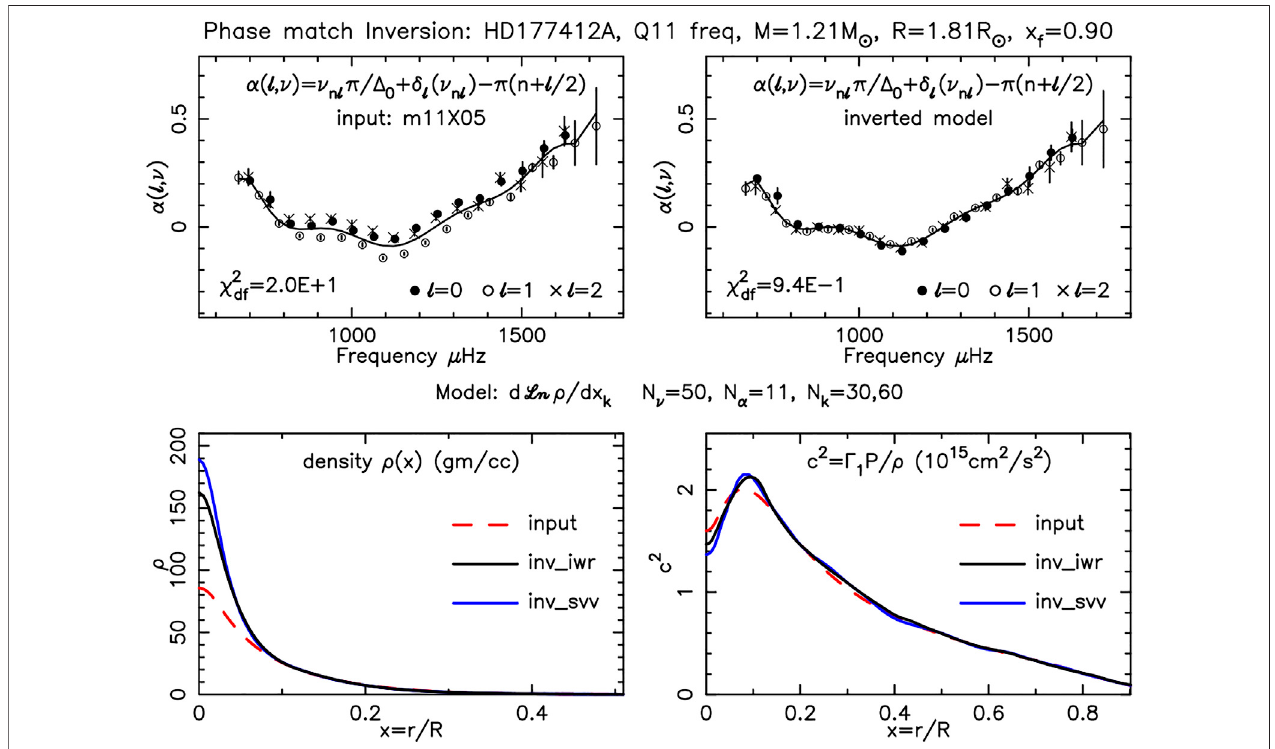
FIGURE12| Inversionresult(black)andinputmodel(red)fortheso-called “ IR ” model.Thepro fi lesresultingfromtheiterativeregularizationinversionof Section6.2 are shown in blue for